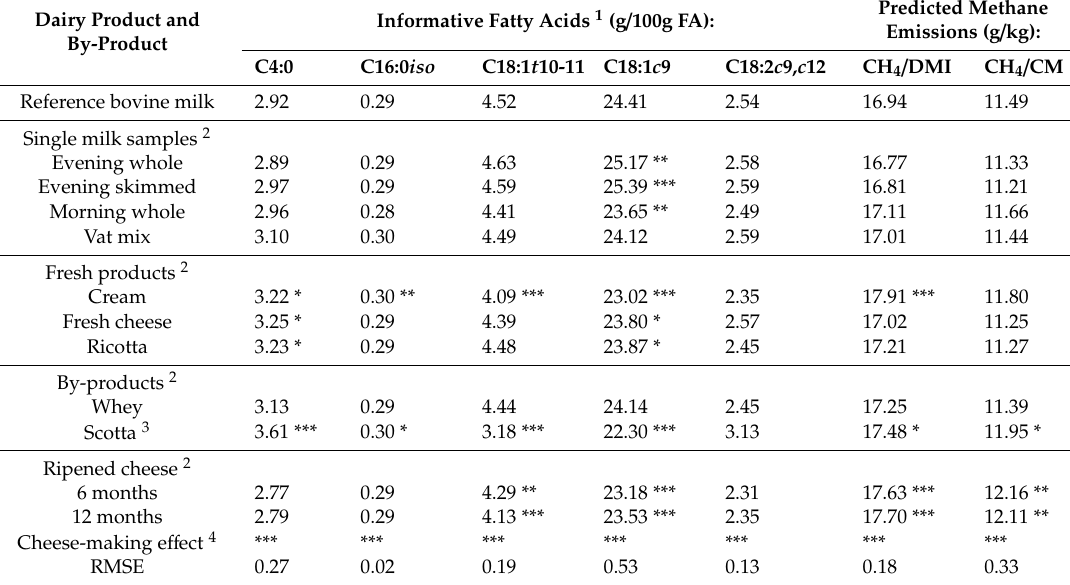
Table 2. Content of informative fatty acids and derived estimated methane yield (per unit dry matter intake, DMI) and intensity (per unit corrected milk, CM) of reference bovine milk (average of whole evening and morning samples) and of other milk samples and dairy products and by-products. Dairy Product and Informative Fatty Acids 1 (g / 100g By-Product